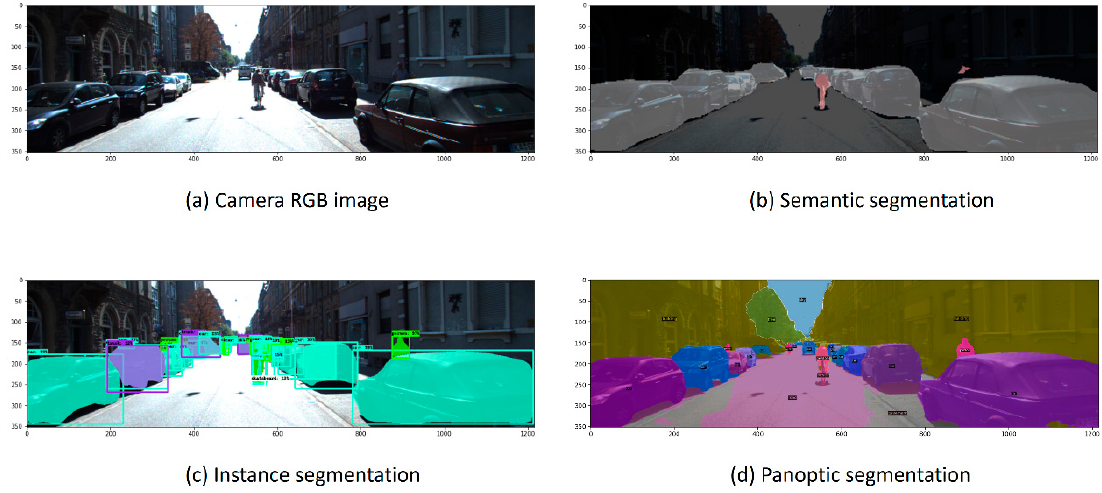
Figure 2. Image segmentation methods [18].